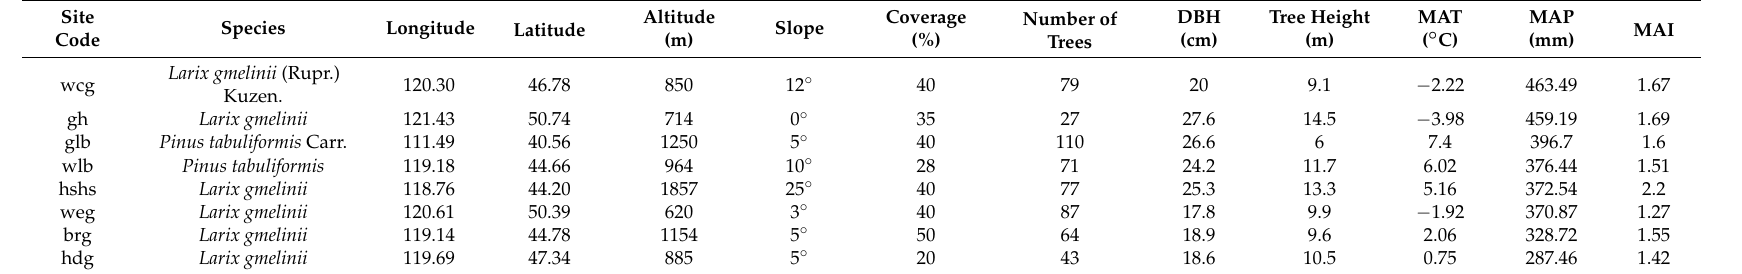
Table 1. The basic information for the eight forest